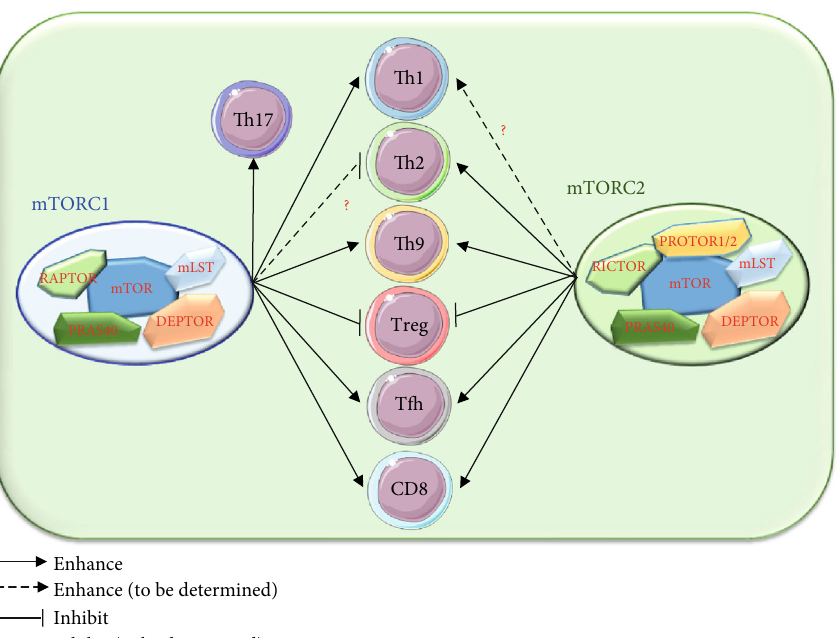
Figure 2: mTORC1 and mTORC2 di ff erently regulate the di ff erentiation of CD4 + Th cell subsets. Th1 and Th17 cell di ff erentiation are positively regulated by mTORC1. Th2 cell di ff erentiation is positively regulated by mTORC2. Both mTORC1 and mTORC2 positively regulate Th9, Tfh, and CD8 cell di ff erentiation. Both mTORC1 and mTORC2 negatively regulate Treg cell di ff